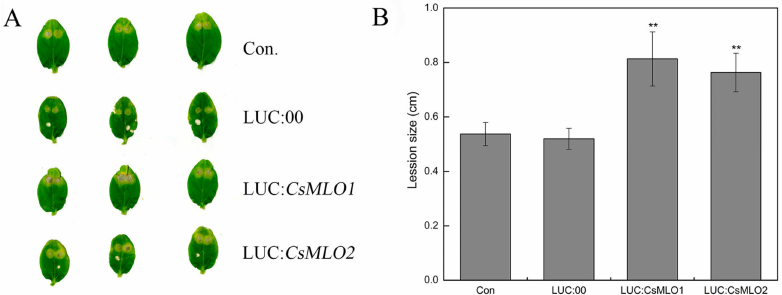
Figure 6. Identification of disease-resistance of transient overexpressing plants after C. cassiicola inoculation. ( A ) The lesion areas were observated in CsMLO1 - and CsMLO2 -transient overexpressing cucumber cotyledons after C. cassiicola inoculation. ( B ) Lesion sizes were measured in CsMLO1 - and CsMLO2 -transient overexpressing cucumber cotyledons after C. cassiicola inoculation. Data are means ± standard deviations from three biological replicates per cultivar. The asterisks indicated a significant di ff erence (Student’s t -test, *P < 0.05 or ** P <